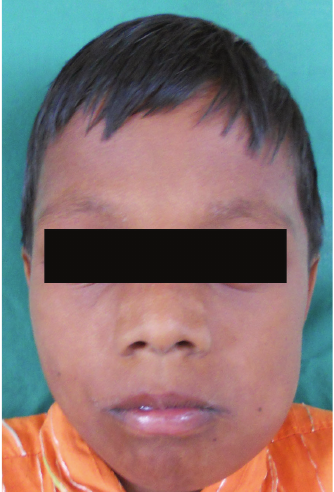
Figure 2: Showing extra oral swelling on left side of face.